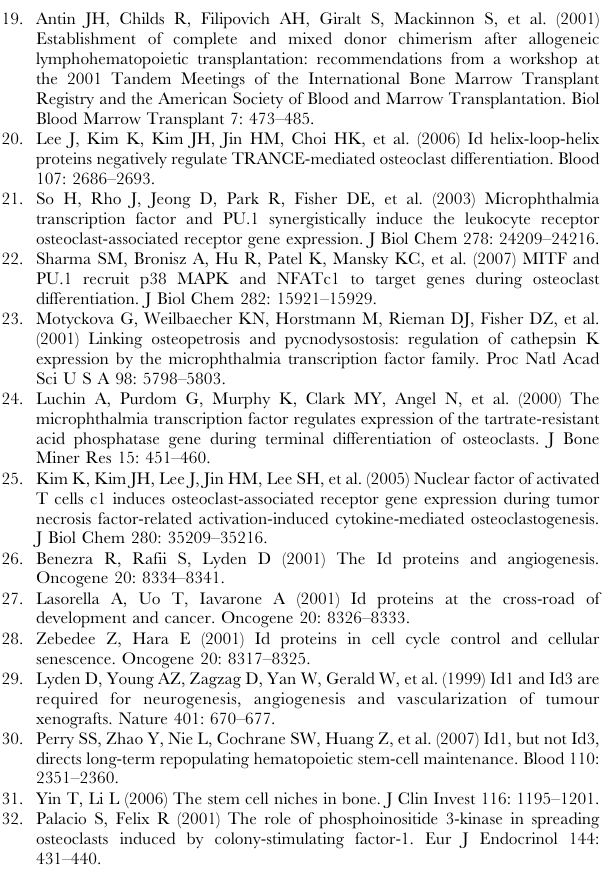
Table S1 Steady state peripheral blood cell counts in wild-type and Id1 2 / 2 mice. Table S2 Characteristics of femurs in CTSK-shRNA and GFP- shRNA BM transplanted